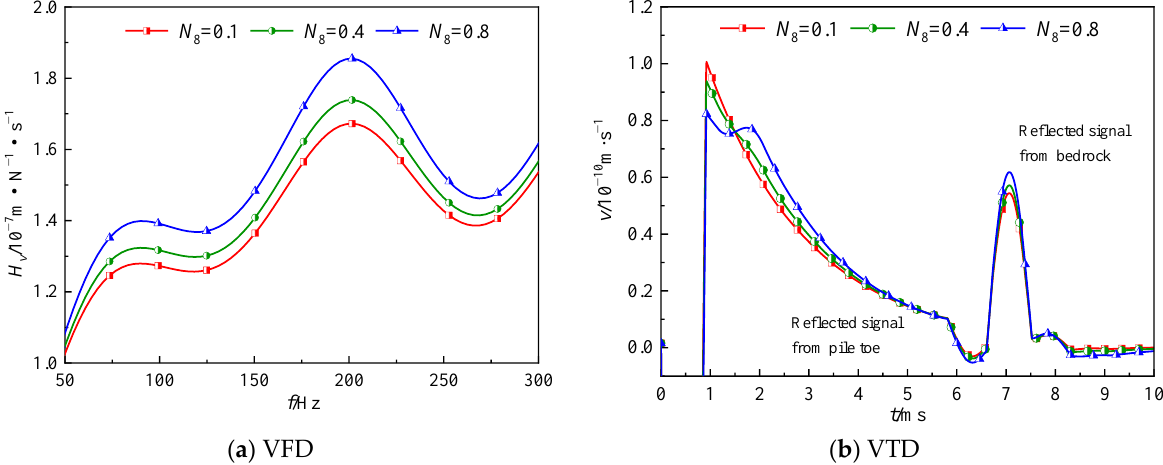
Figure 8. Effect of the porosity of the saturated soils around the pile on pile vertical vibration.